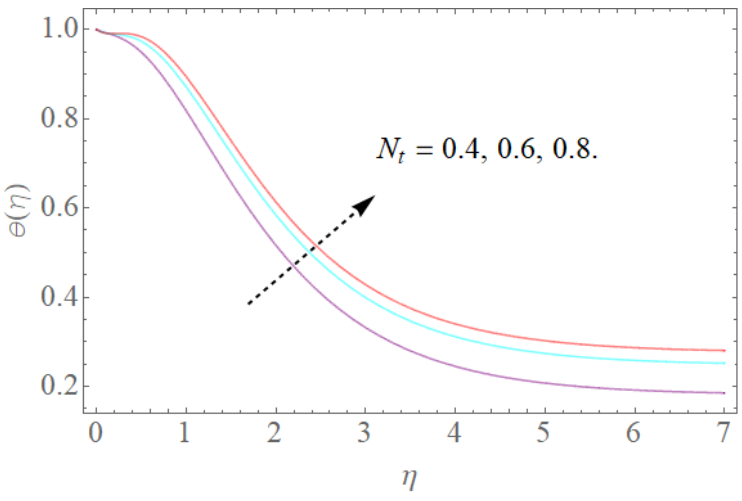
Figure 11. The effect of N t on θ ( η ) when N b = 0.3, α = 1.0,Pr =